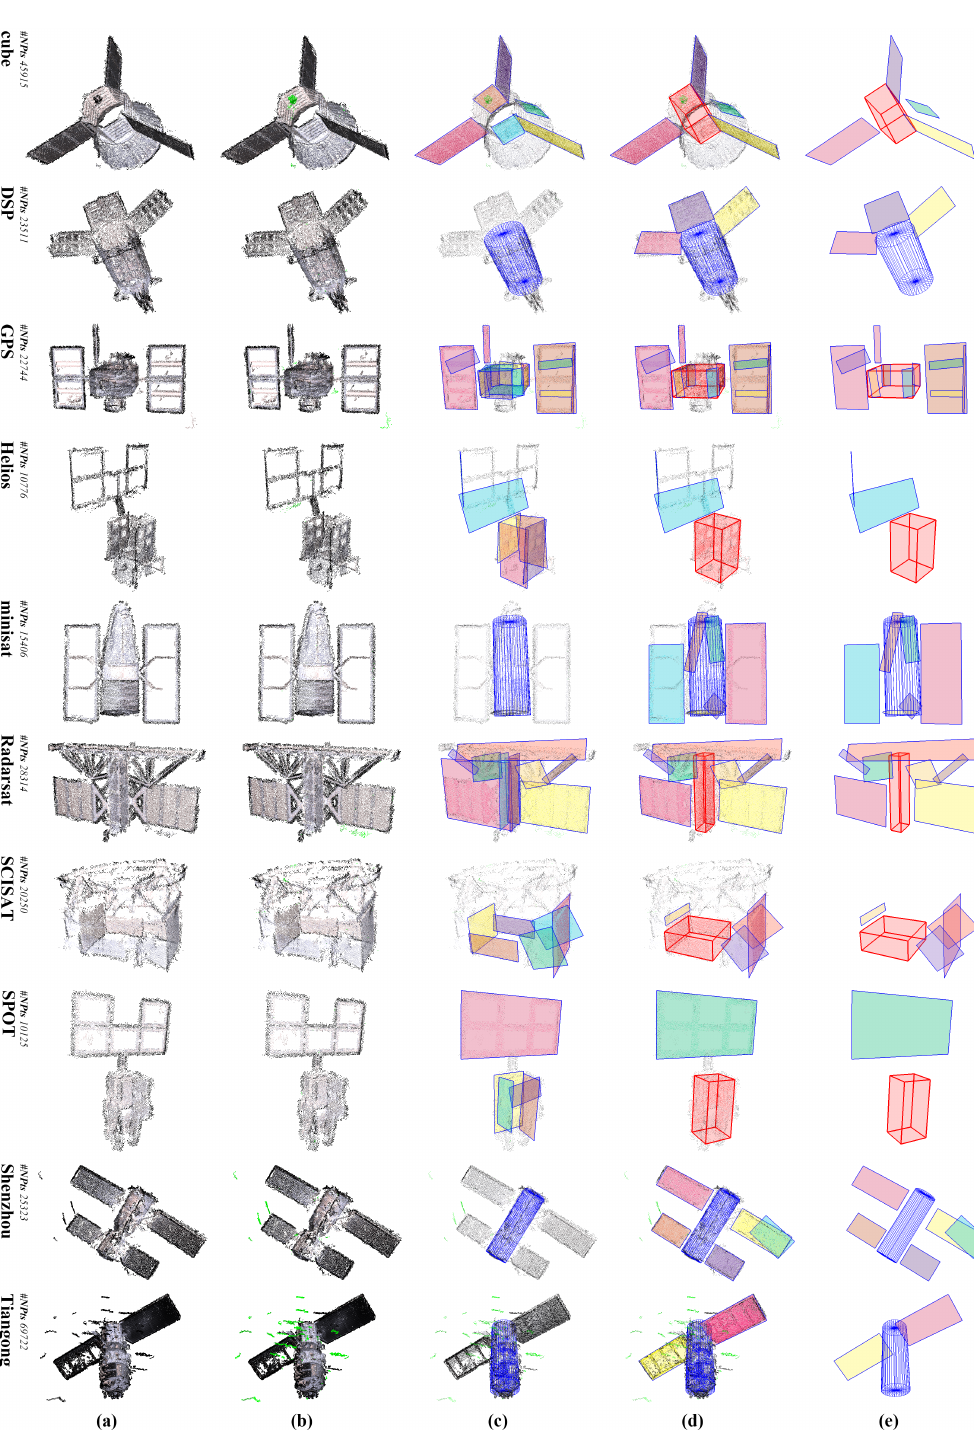
Figure 2. Detection results of the reconstructed point cloud data. From left to right: ( a ) the origin input point clouds; ( b ) results of outliers removal, where the identified outliers are colored in green; ( c ) results of cylinder detection or patch detection; the cylinders are rendered in blue, and patches are rendered in different colors; ( d ) final results; the detected cuboids are rendered as red boxes; ( e ) a clear view of the detected components. The number of points (#NPts) is noted above model